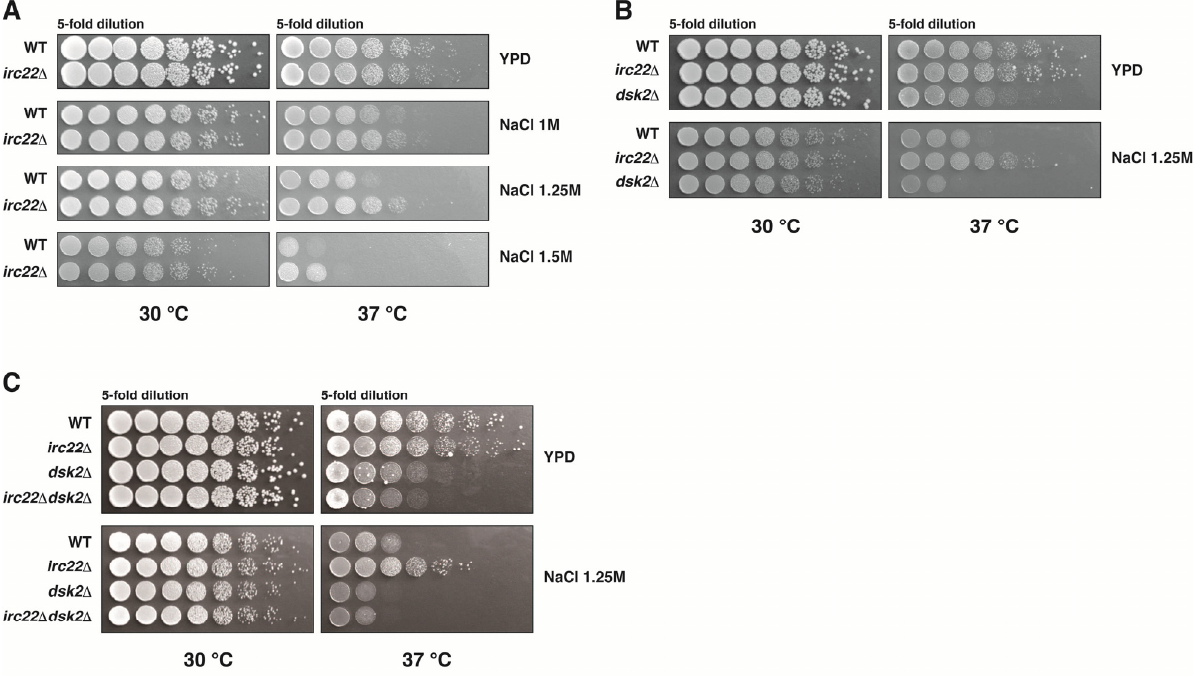
Figure 4. Dsk2 and Irc22 are involved in salt stress tolerance in yeast. ( A ) Growth tolerance to NaCl stress induced by IRC22 disruption. Wild-type and irc22 Δ cells were grown in YPD medium and spotted onto YPD plates containing 1.0–1.5 M NaCl at 30 °C or 37 °C in fivefold serial dilutions. ( B ) Growth sensitivity to NaCl stress induced by DSK2 disruption. Wild-type, irc22 Δ and dsk2 Δ cells were grown in YPD medium and spotted onto YPD plates containing 1.25 M NaCl at 30 °C or 37 °C in 5-fold serial dilutions. ( C ) Disappearance of salt tolerance by irc22 Δ dsk2 Δ double disruption. Wild-type, irc22 Δ , dsk2 Δ ) and irc22 Δ dsk2 Δ cells were grown in YPD medium and spotted onto YPD plates containing 1.25 M NaCl at 30 °C or 37 °C in 5-fold serial dilutions. ( D ) Growth tolerance to CaCl and KCl stresses induced by IRC22 disruption. Wild-type 2 and irc22 Δ cells were grown in YPD medium and spotted onto YPD plates containing KCl (0.1–0.4 M; right panel) at 30 °C or 37 °C in 5-fold serial (1.0–1.5 M; left panel) or CaCl 2 dilutions. ( E ) Disruption of IRC22 affects neither DNA damage nor oxidative stresses. Wild-type and irc22 Δ cells were grown in YPD medium. Left panel: cells were spotted onto YPD plates in fivefold serial dilutions and exposed to 50 J/m 2 or 100 J/m 2 UV O irradiation at 30 °C. Right panel: cells were spotted onto YPD plates containing H 2 2 (0. 5 mM and 1 mM) at 37 °C in fivefold serial